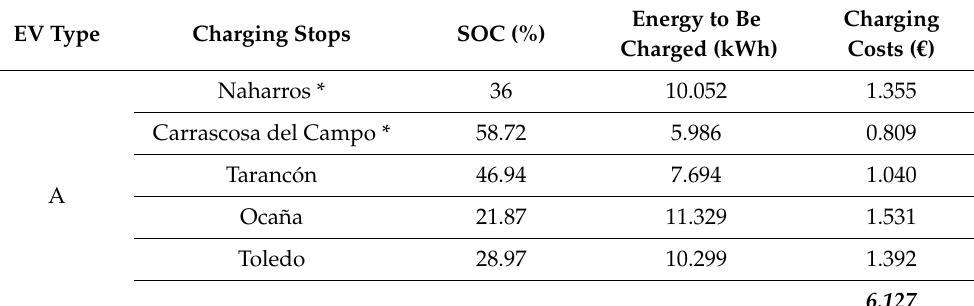
Table 9. Simulation results for EV type A on the Cuenca–Toledo